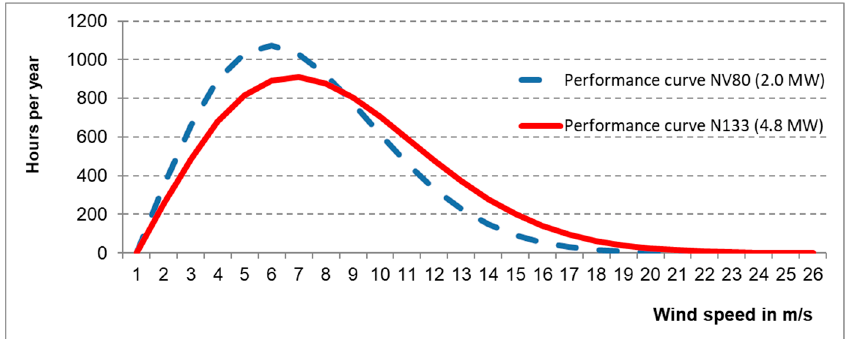
Figure 5. Performance curve as a Weibull distribution (according to [10]) of the old wind turbine (V80) and the new system (N133). Source: Own illustration.